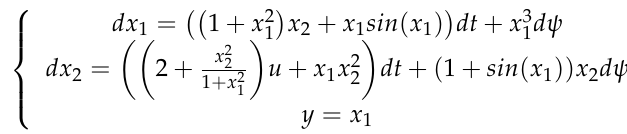
Figure 3. Block diagram of the proposed control system.